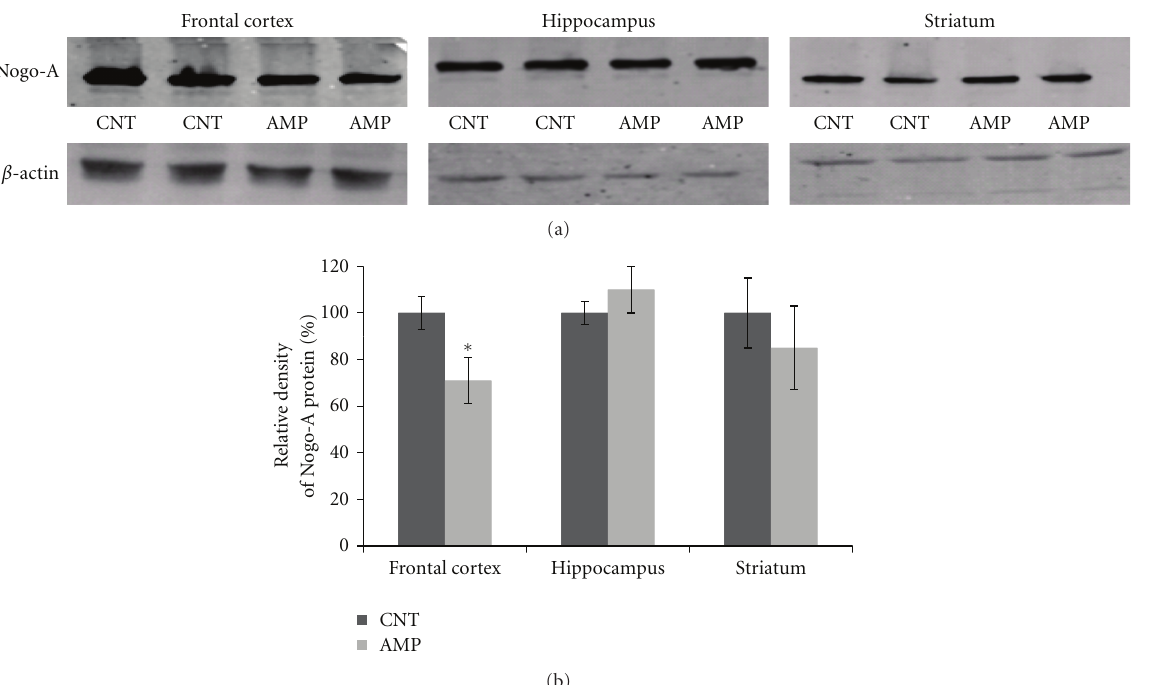
Figure 2: AMP reduced the amount of Nogo-A protein in the frontal cortex. After treating with d-AMP or a same volume of saline for 21 days and subjected to behavioral tests, mice were sacrificed, their brains were dissected, and tissue samples from specific brain regions were processed for Western blot analysis. The amount of Nogo-A protein in the frontal cortex, hippocampus, and striatum was measured. (a) shows representative Western blot images and (b) is a bar chart illustrating the statistical analysis of the Western blot results. Data were expressed as means ± SEM. Comparisons were made between CNT and AMP groups. ∗ P < 0 . 05. Of 6 PFC samples in AMP group, one showed a ratio (1.5) of Nogo-A protein/ β -actin higher than the average of CNT group (1.4). PBS rinses, the sections were incubated in an avidin-biotin- horseradish peroxidase complex (ABC) for 1 h at 22 ◦